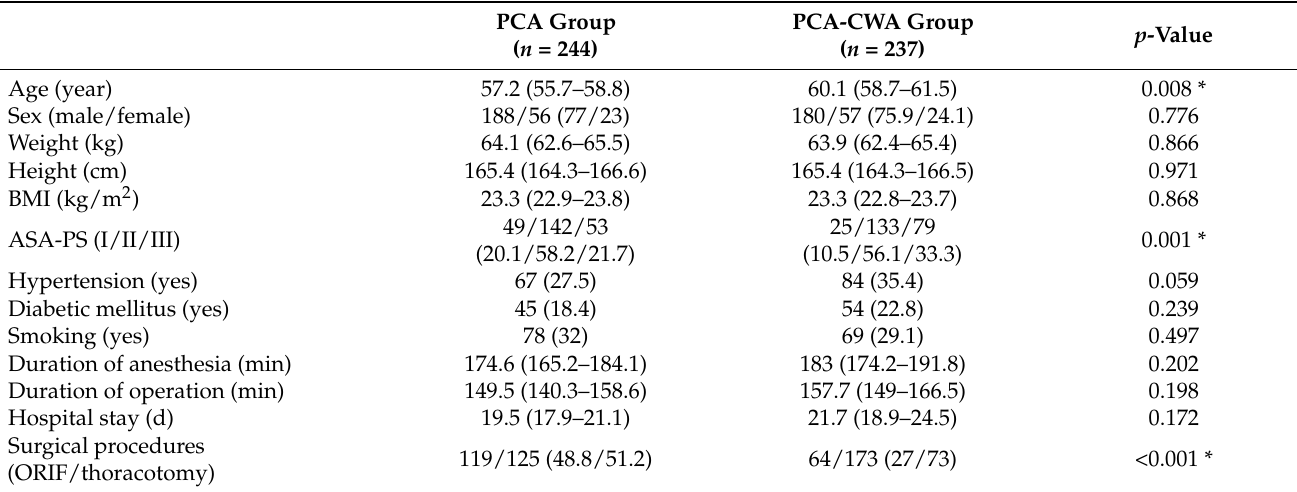
Table 1. Demographic and clinical data before propensity score matching.